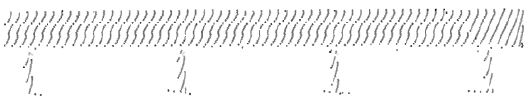
Figure 17. Point-cloud of a guardrail consisting of beams